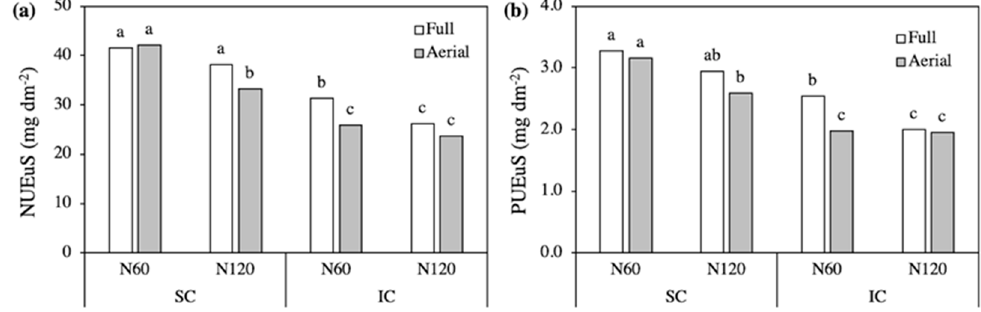
Figure 4. Nitrogen ( a ) and phosphorus ( b ) uptake efficiency per unit of root surface in field bean, as affected by the Crop system × N level × Row contact interaction. SC, sole crop; IC, intercrop. Values are the mean of three replicates. In each figure, bars with di ff erent letters indicate that the corresponding means are significantly di ff erent at P < 0.05, Tukey’s